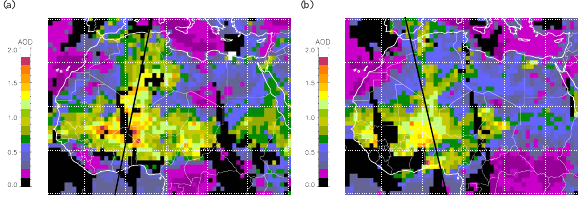
Fig.5. MODIS-derivedAOD at670nm overWestAfricafrom13June (a) to14June (b) 2006withCALIPSOtracks(blackline). Fig. 5. MODIS-derived AOD at 670nm over West Africa from 13 June (a) to 14 June (b) 2006 with CALIPSO tracks (black